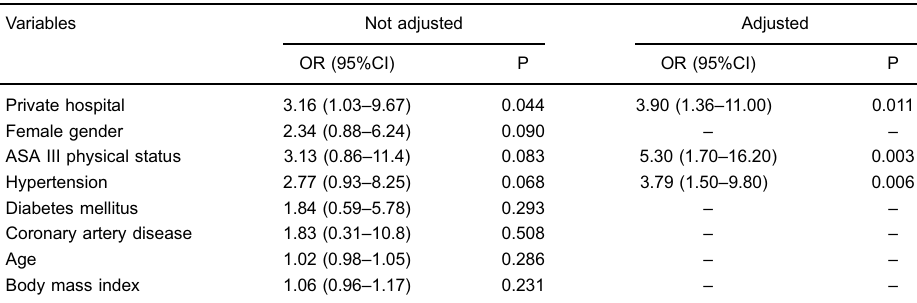
Table 4. Multivariate analysis of factors associated with coronary artery disease (CAD) screening in asymptomatic patients scheduled for low and medium-risk surgeries with moderate functional capacity ( X 04 MET, metabolic equivalents) in Salvador, BA, Brazil